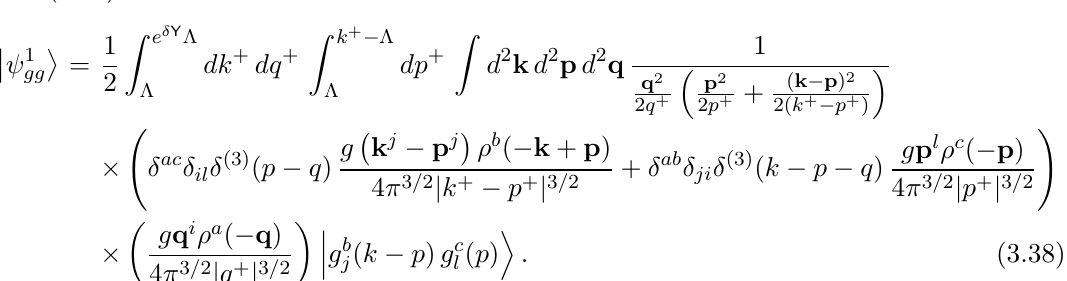
Figure 5 . Two gluon producation diagrams. (a) -